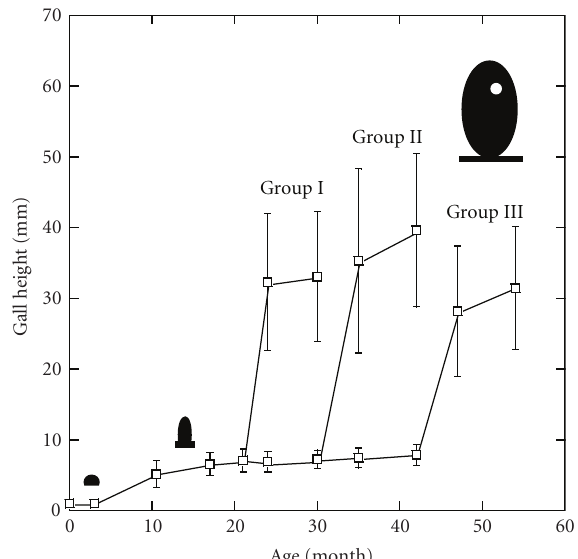
Figure 2: Development of galls of Nipponaphis monzeni formed on a tree (Tree N). Gall height is indicated as mean (square) ± SD (vertical bar). Groups I, II, and III correspond to the first, second, and third expanding groups, respectively, in the